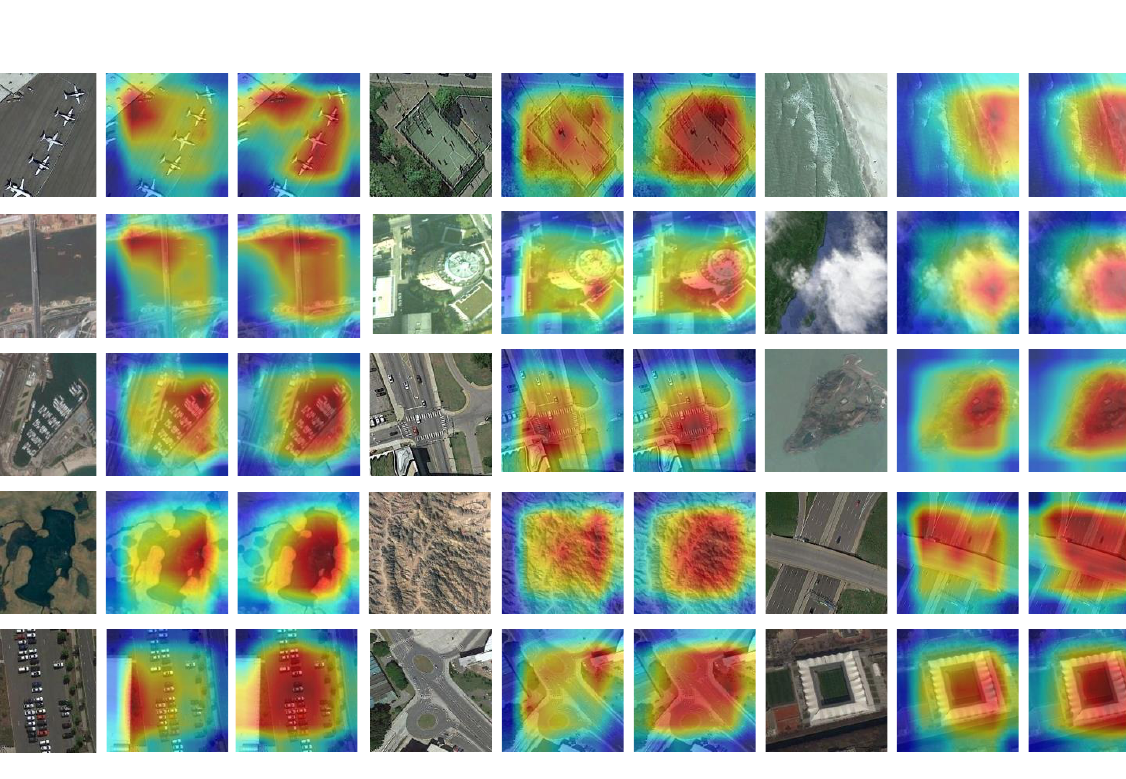
Figure 6. Examples of the CAMs generated from the NWPU-RESISC45 data set. We show the original images, CAMs generated from fine-tuned MobileNetV2 and DMP-MobileNetV2,